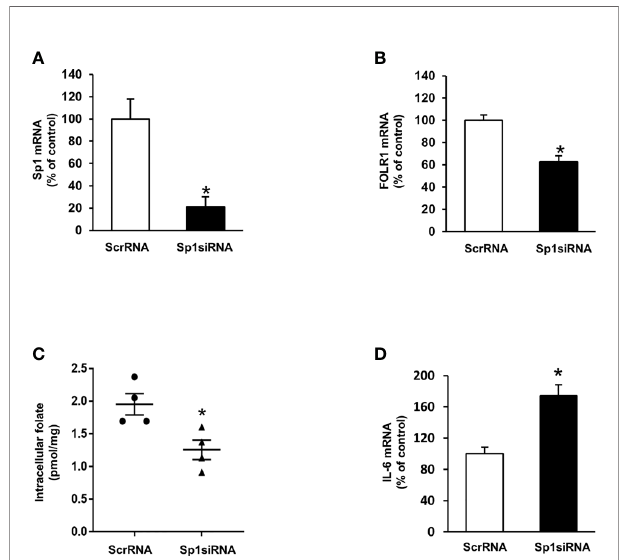
FIGURE 6 | Effect of Sp1 siRNA transfection on folate receptor expression, folate content and IL-6 expression in proximal tubular cells. Cells were transfected with Sp1 siRNA or scrambled RNA (ScrRNA) as a control. (A) Sp1 mRNA, (B) folate receptor (FOLR-1) mRNA, (C) intracellular folate and (D) IL-6 mRNA was determined by real-time PCR analysis. Results are expressed as means ± SE (n = 4-6). * P < 0.05 when compared with the value obtained from cells transfected with